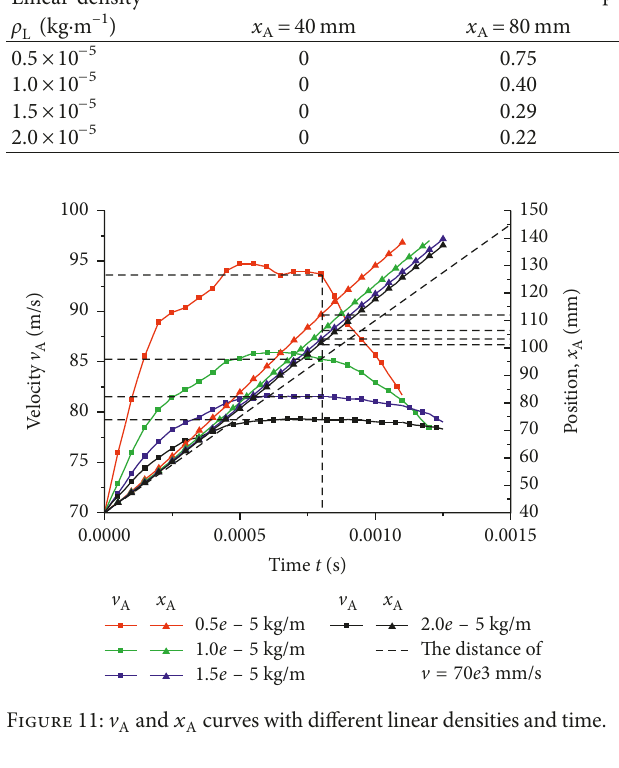
Table 1: Standard deviation of fiber fluctuations with different fiber linear densities at different positions. Linear density